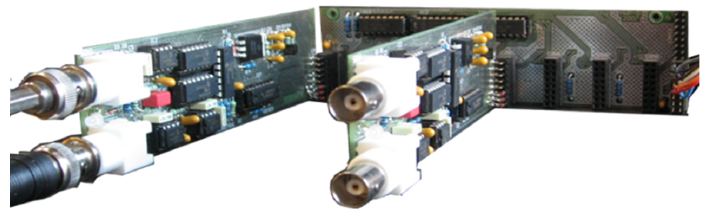
Figure 3. Hot-wire anemometer with automatically adjusted dynamic properties. Table 1. Hot-wire anemometer—specification.